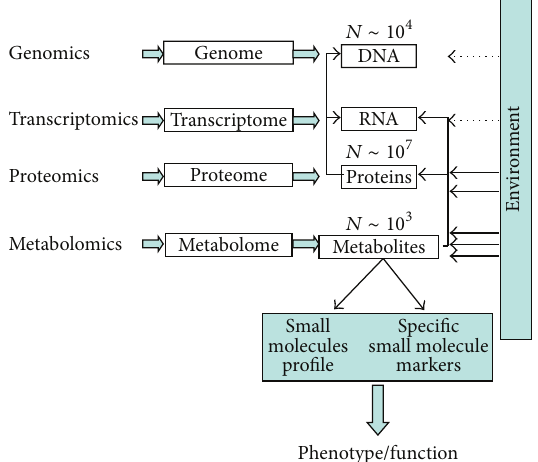
Figure 1: Relationships between the omics